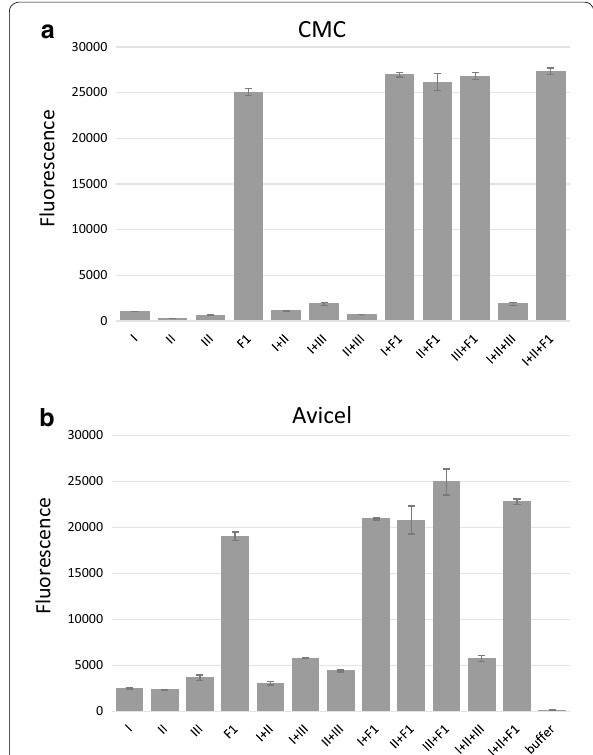
Fig. 6 Activity of F1 (in heated, 65 °C, 20 min, crude cell extract) on a CMC and b Avicel as a substrate, detected as fluorescence by the Amplex Ultra Red based on H 2 O 2 formed by glucose oxidase from enzyme reactions generating glucose. Enzyme I indicates endoglu- canase (Sigma E2164), Enzyme II indicates cellobiohydrolase (Sigma E6412) and Enzyme III indicates beta-glucosidase (Sigma 49290). For assay using CMC, all enzymes were diluted 5x compared to the Avicel reaction in order to resolve results. Error bars represent standard deviations from three independent